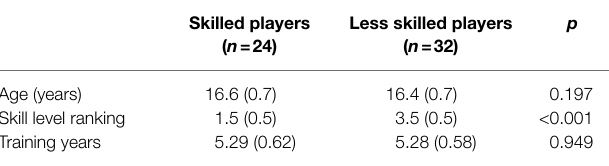
TABLE 1 | Characteristics of skilled and less skilled adolescent soccer players.